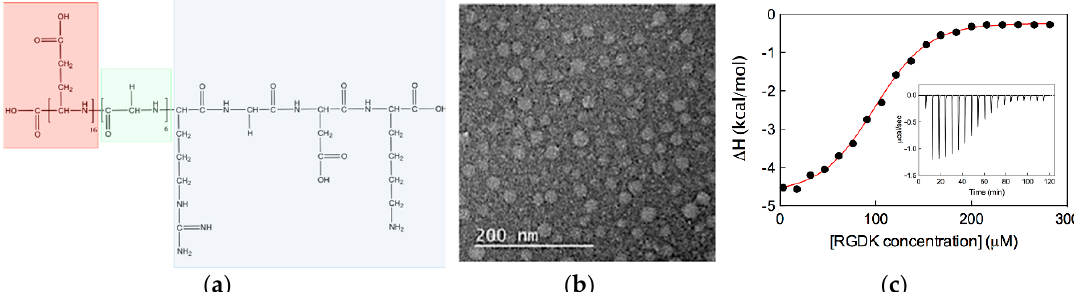
Figure 13. ( a ) Chemical structure of the E 16 G 6 RGDK peptide designed as a double targeting moiety for enhancing the siRNA delivery to cancer cells mediated by the double-tail self-assembling AD dendron. The light red box encases the E 16 fragment, the light green box marks the G 6 spacer while the light blue box highlights the RGDK warhead. ( b ) TEM imaging of the siRNA/ AD / E 16 G 6 RGDK nanosized micelles formed upon simple addition of the targeting peptide to pre-formed siRNA/ AD complexes. ( c ) Integrated ITC profile for the titration of siRNA/ AD complexes with the E 16 G 6 RGDK peptide. The solid red line represents data fitting with a sigmoidal function. The insert shows the corresponding ITC raw data. Adapted from [8] with permission of the American Chemical Society, 2018.